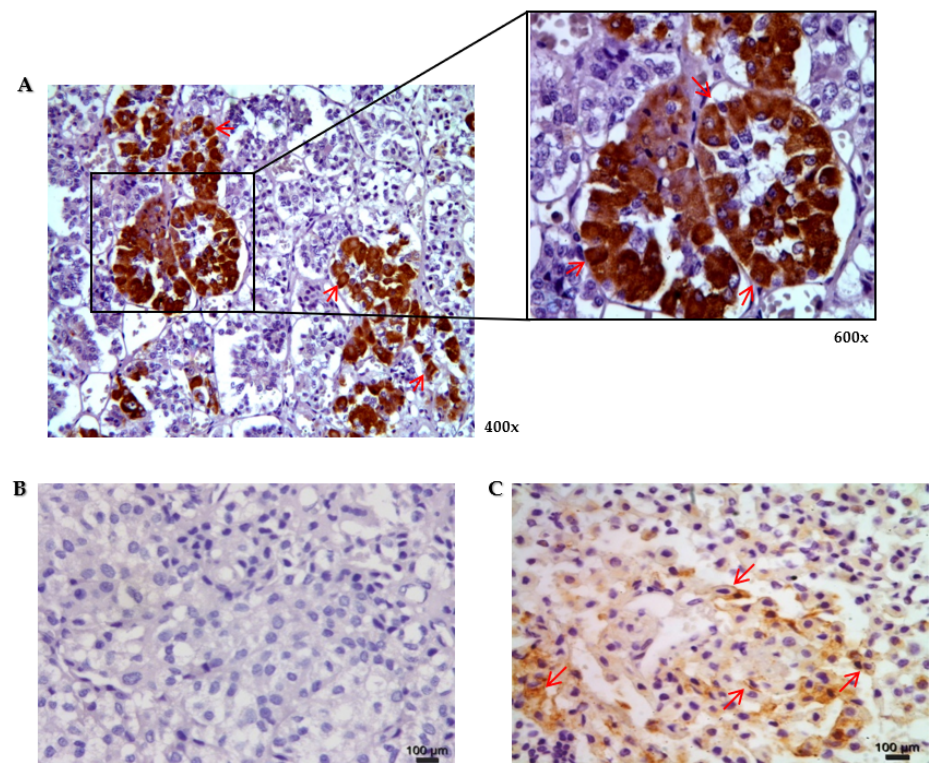
Figure 1. Representative microphotographs of immunohistochemical staining for connexin 43 (Cx43) in normal human pituitary and pituitary neuroendocrine tumors. ( A )—The immunoreactivity of Cx43 was observed both in the cell membrane and/or in the cytoplasm in more than 50% of the cells of the adenohypophysis. ( B , C )—Immunohistochemical staining for Cx43 in pituitary neuroendocrine adenomas. Variable immunoreactivity of Cx43 was observed in the cell membranes and/or in the cytoplasm of the pituitary adenomas. The red arrows highlight the presence of Cx43 membrane expression. Table 3. Immunoreactivity score of the protein expression of connexin 43 in pituitary neuroendocrine tumor